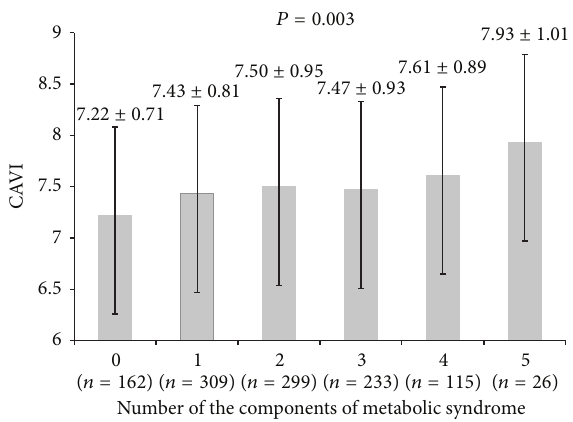
Figure 3: The relation between cardioankle vascular index (CAVI) and the number of components of metabolic syndrome. 𝑃 values were calculated by ANOVA and age-adjusted CAVI.